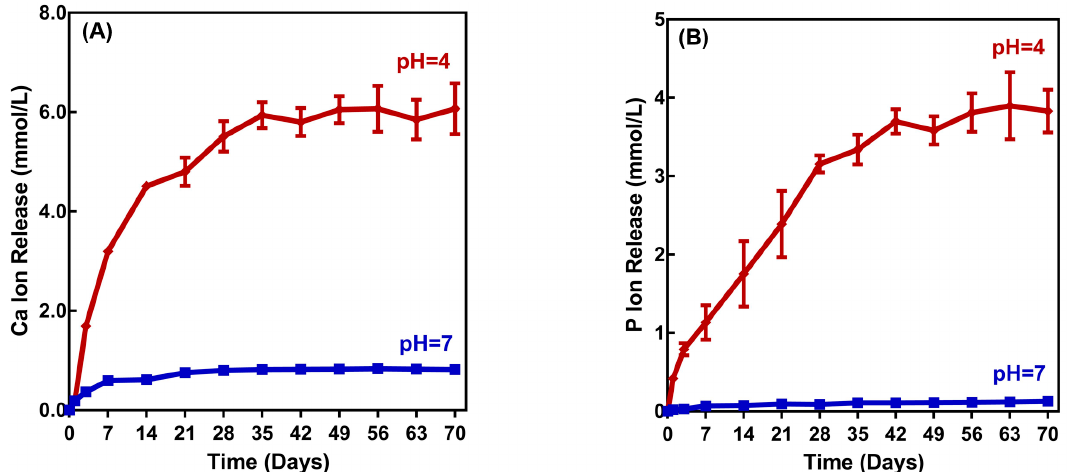
Figure 5. Calcium (Ca) and phosphate (P) ion releases from the 3DMAHDM + 30NACP composite immersed in solutions of pH 4 and 7. ( A ) Ca ion release, and ( B ) P ion release.